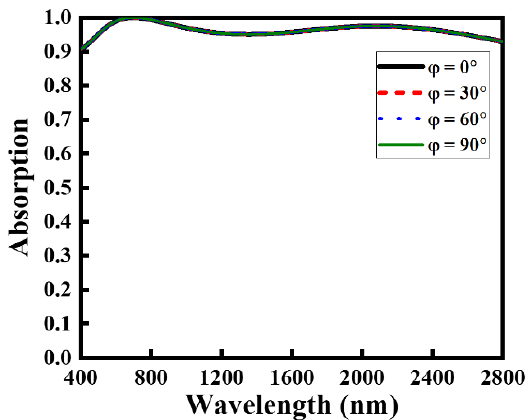
Figure 5. The optical absorption rate of the proposed NMMA under the variation of polarization angles of the incoming light.